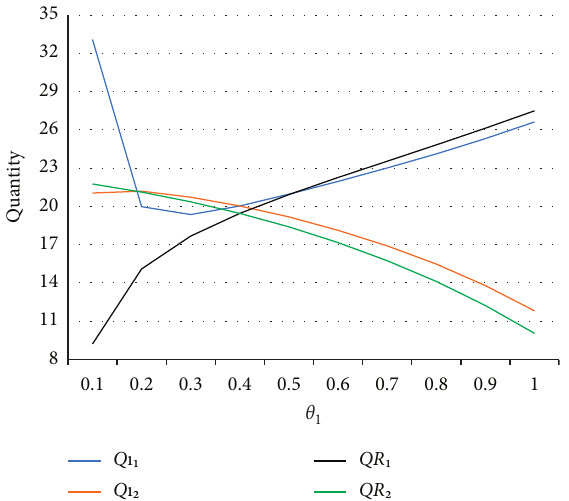
Figure 2: The impact of θ